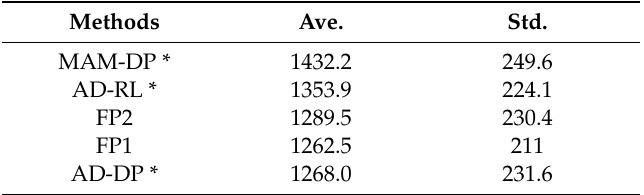
Table 7. The average expected value and the standard deviation of annual benefit.